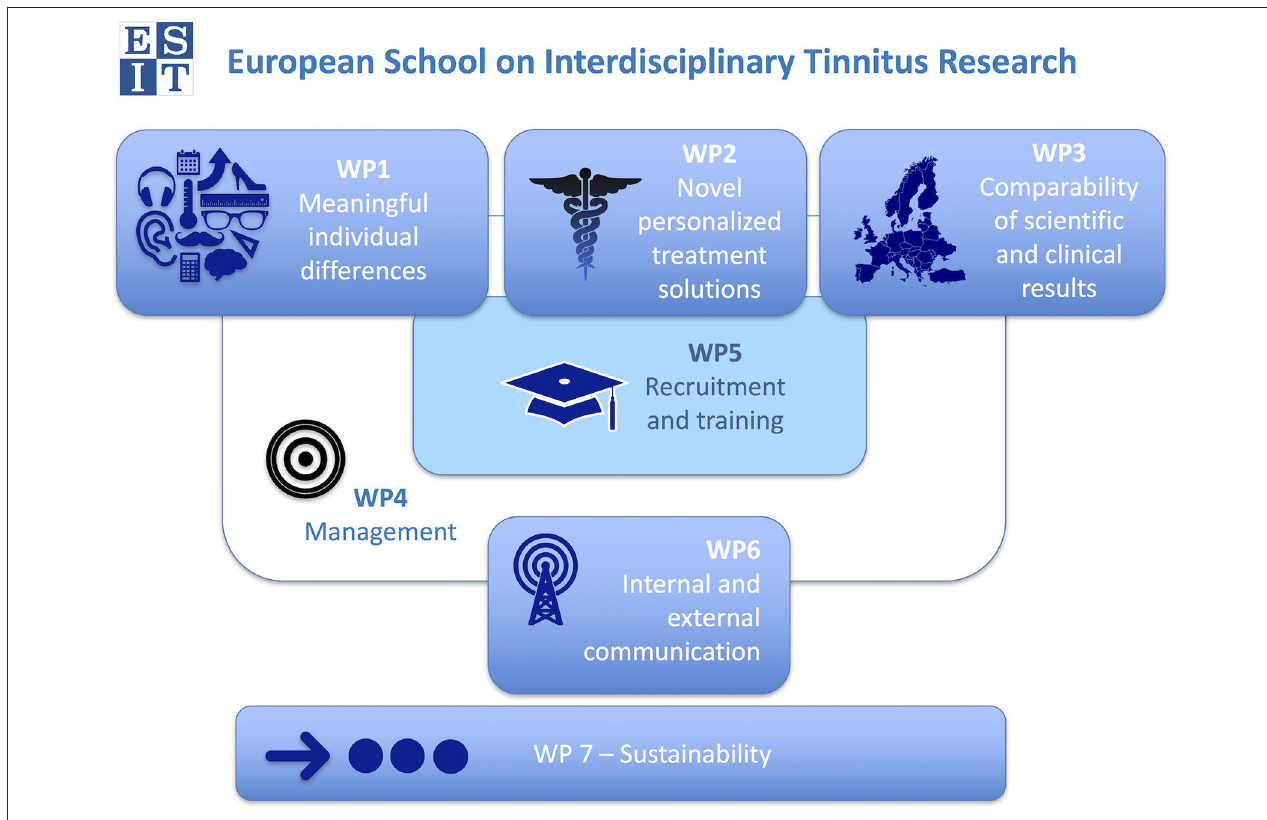
FIGURE 1 | The ESIT structure. Work packages 1–3 deliver the research projects, Work package 4 is to ensure the fluent and effective management of ESIT, Work package 5 is to coordinate the training and recruitment of the students, Work package 6 manages the internal and external communication, and Work package 7 ensures the sustainability of the ESIT achievements. Work packages 4–7 are led by the University of Regensburg, University of Nottingham, Karolinska Institute in Stockholm, and University of Regensburg,